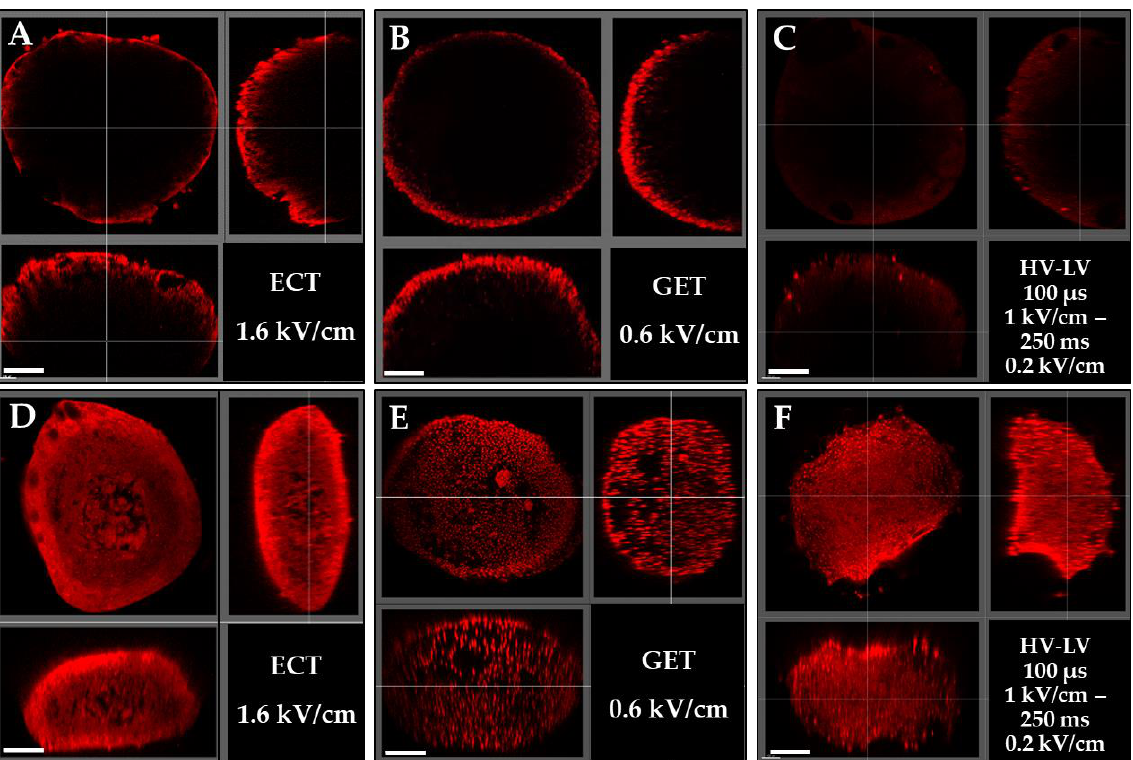
Figure 6. Representative 3D images of HCT-116 GFP spheroids electropermeabilization. Spheroids were incubated with 200 mM PI and treated with ECT pulse parameters (8 pulses of 100 µs, 1.6 kV/cm at 1 Hz) ( A , D ), GET pulse parameters (10 pulses of 5 ms, 0.6 kV/cm at 1 Hz) ( B , E ) and HV-LV pulse parameters (100 µs at 1 kV/cm — 250 ms at 0.2 kV/cm) ( C , F ). One hour after treatment, spheroid were fixed and observed by biphotonic microscopy ( A – C ) and compared with spheroids that underwent tissue clearing ( D – F ). Top left: front view, top right: transversal view, up left: sagittal view on an optical plane inside the spheroid. Scale bar = 200 µm. N = 2 independent experiments, 4 spheroids per experiment.